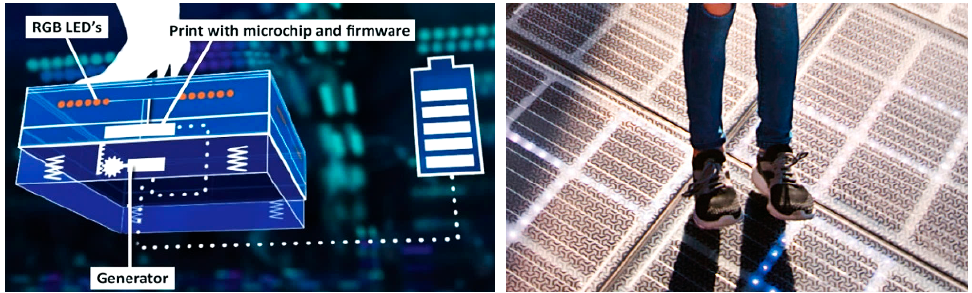
Figure 33. Working principle of the Sustainable Energy Floor ® [77].